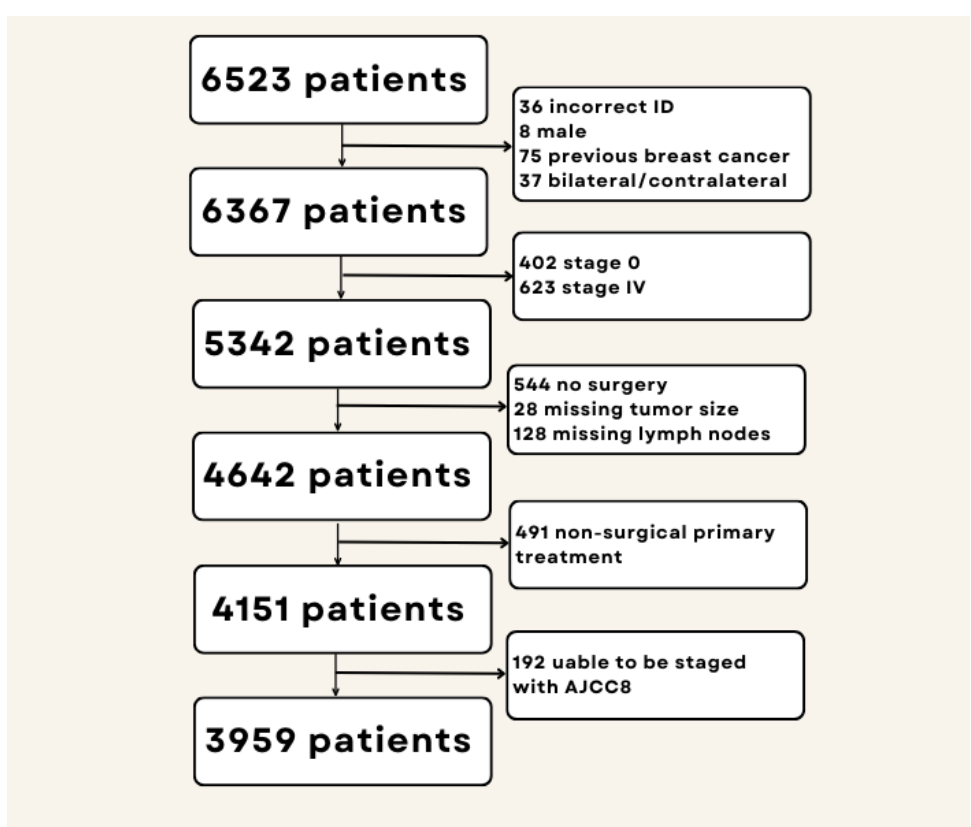
Figure 1. Selection flowchart of the study population.